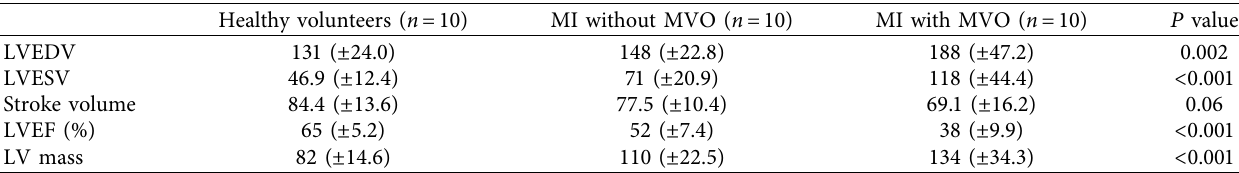
Table 2: Cardiac MRI results stratifed by clinical